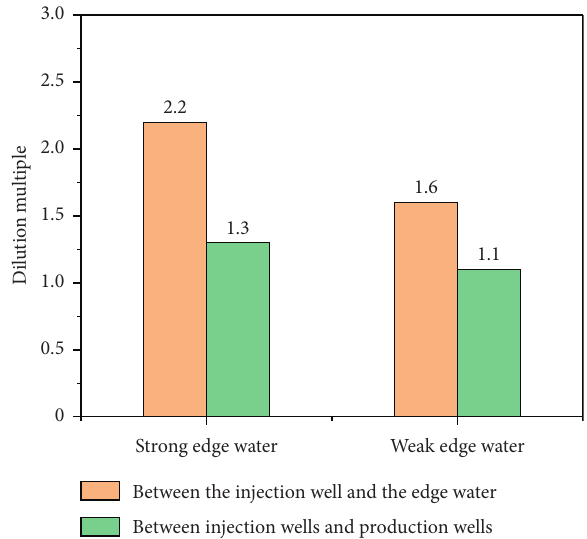
Figure 14: Dilution multiple of different regions under the strong and weak edge water conditions.